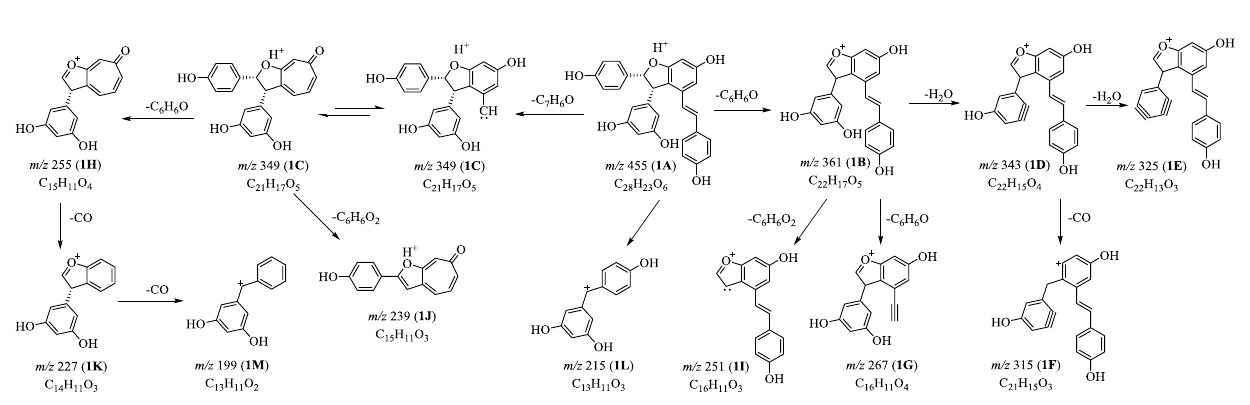
Fig. 1 Structures of compounds 1 – 4